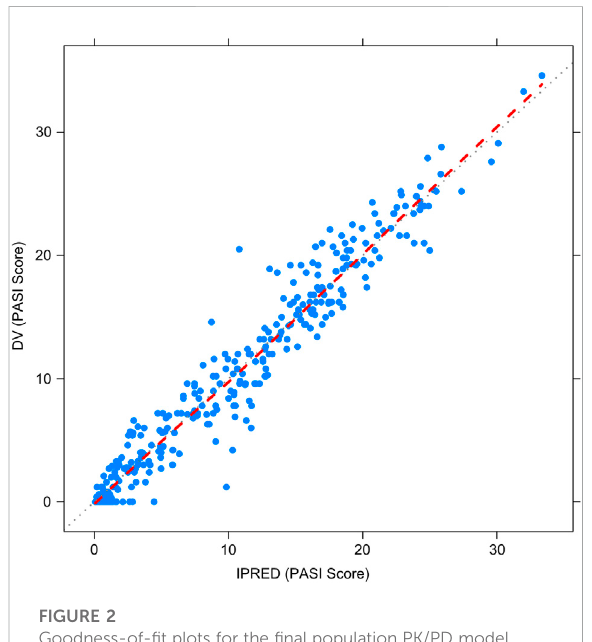
FIGURE 2 Goodness-of- fi t plots for the fi nal population PK/PD model. Observed PASI score (DV) vs. Individual-predicted PASI score (IPRED).